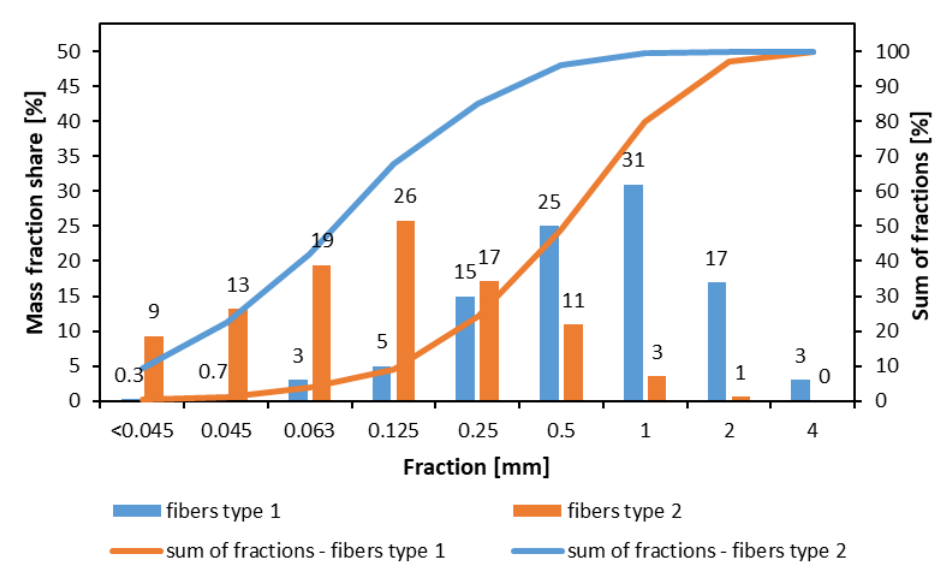
Figure 1. The morphological characteristics of the fibers.